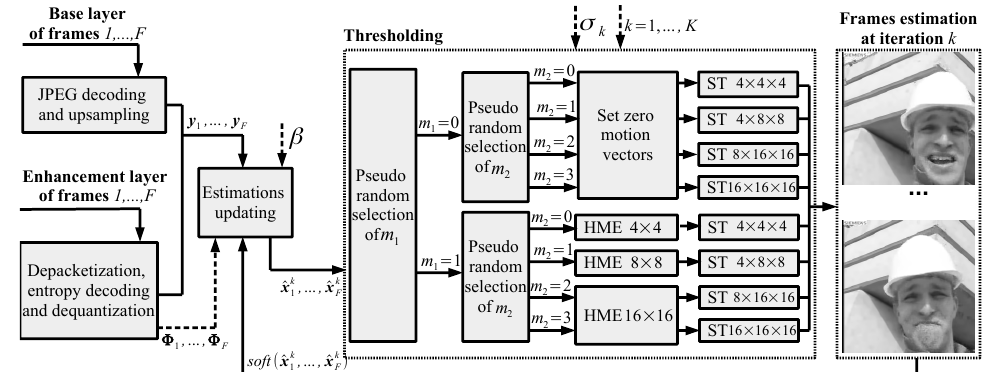
Figure 6. Proposed fast randomized ISTA for CS-JPEG decoder.